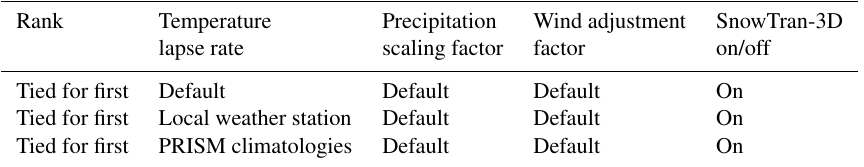
Table B1. Top-performing parameter configurations from the calibration simulations.